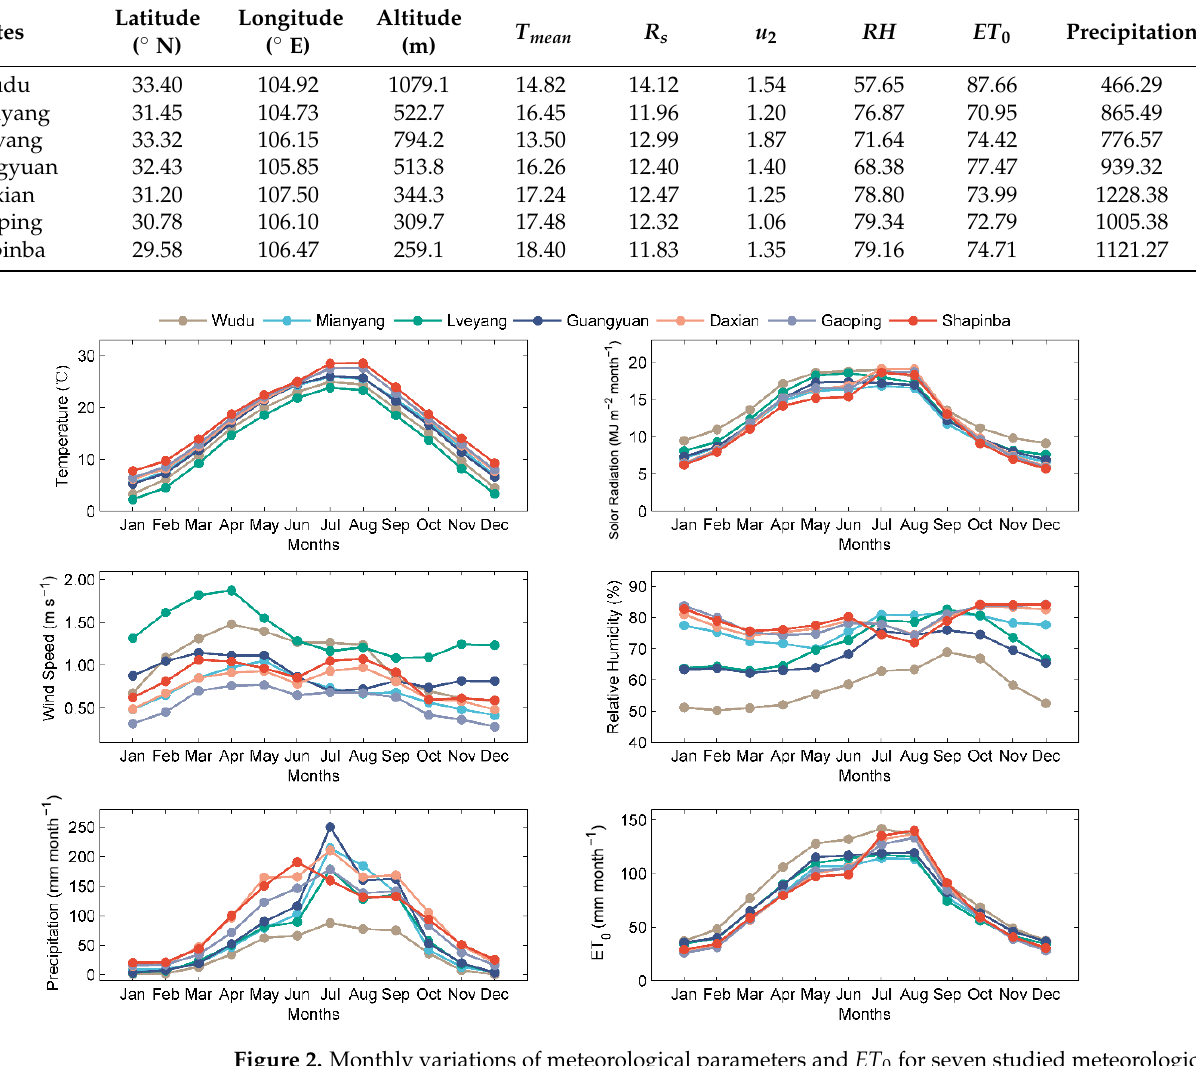
Figure 2. Monthly variations of meteorological parameters and ET 0 for seven studied meteorological stations during 1964 – 2014.